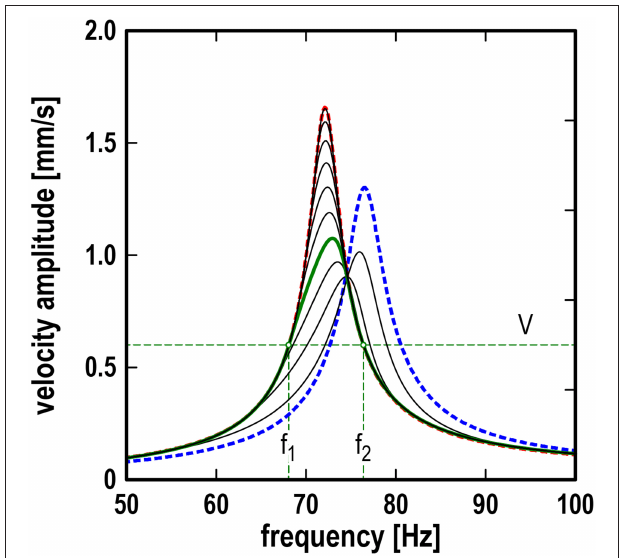
FIGURE 3 | Dependencies of the amplification factor (ratio of rigid arm amplitude to excitation amplitude) on excitation frequency for six different friction coefficients in the range from 0.1 to 1.0; blue broken line: case II (static contact); red broken line: case III (fully slipping